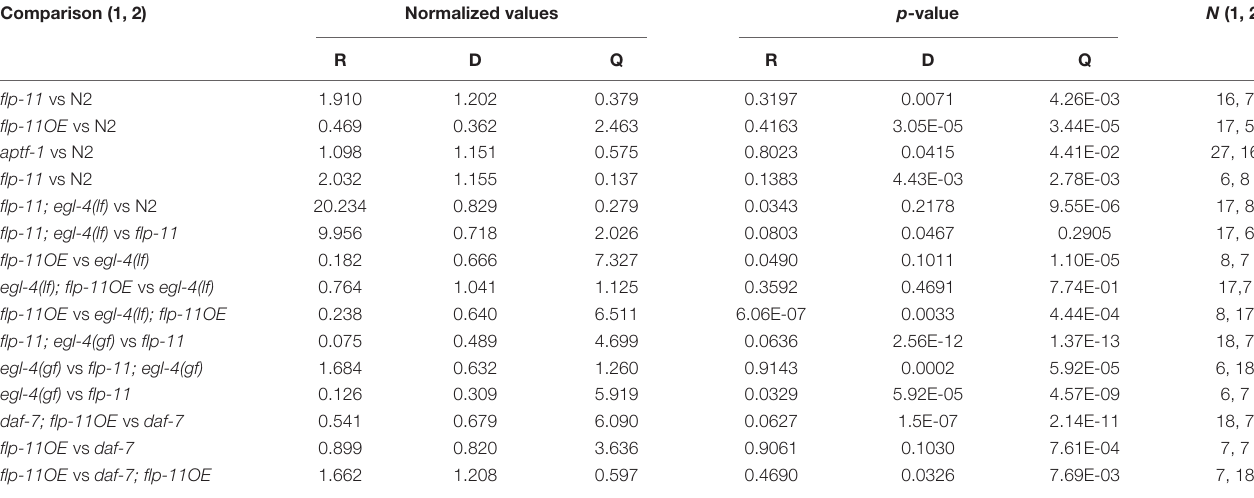
TABLE 2 | Normalized values of each state of roaming, dwelling and quiescence, the sample size, and statistical significance of flp-11 , flp-11OE , egl-4(lf) , egl-4(gf) , daf-7 , and the double mutants. Comparison (1,